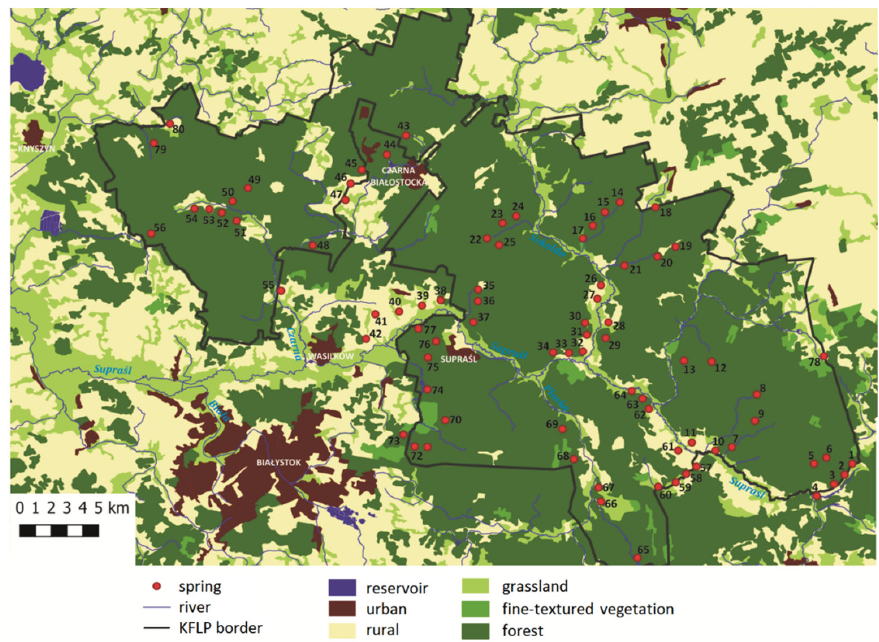
Figure 10. Land use in the Knyszy ń ska Forest in comparison with the distribution of springs.